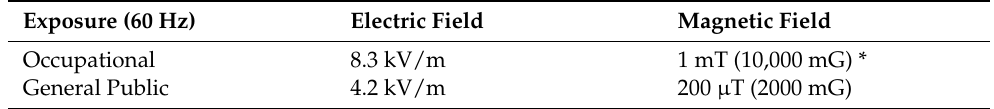
Table 2. ICNIRP guidelines for EMF exposure.